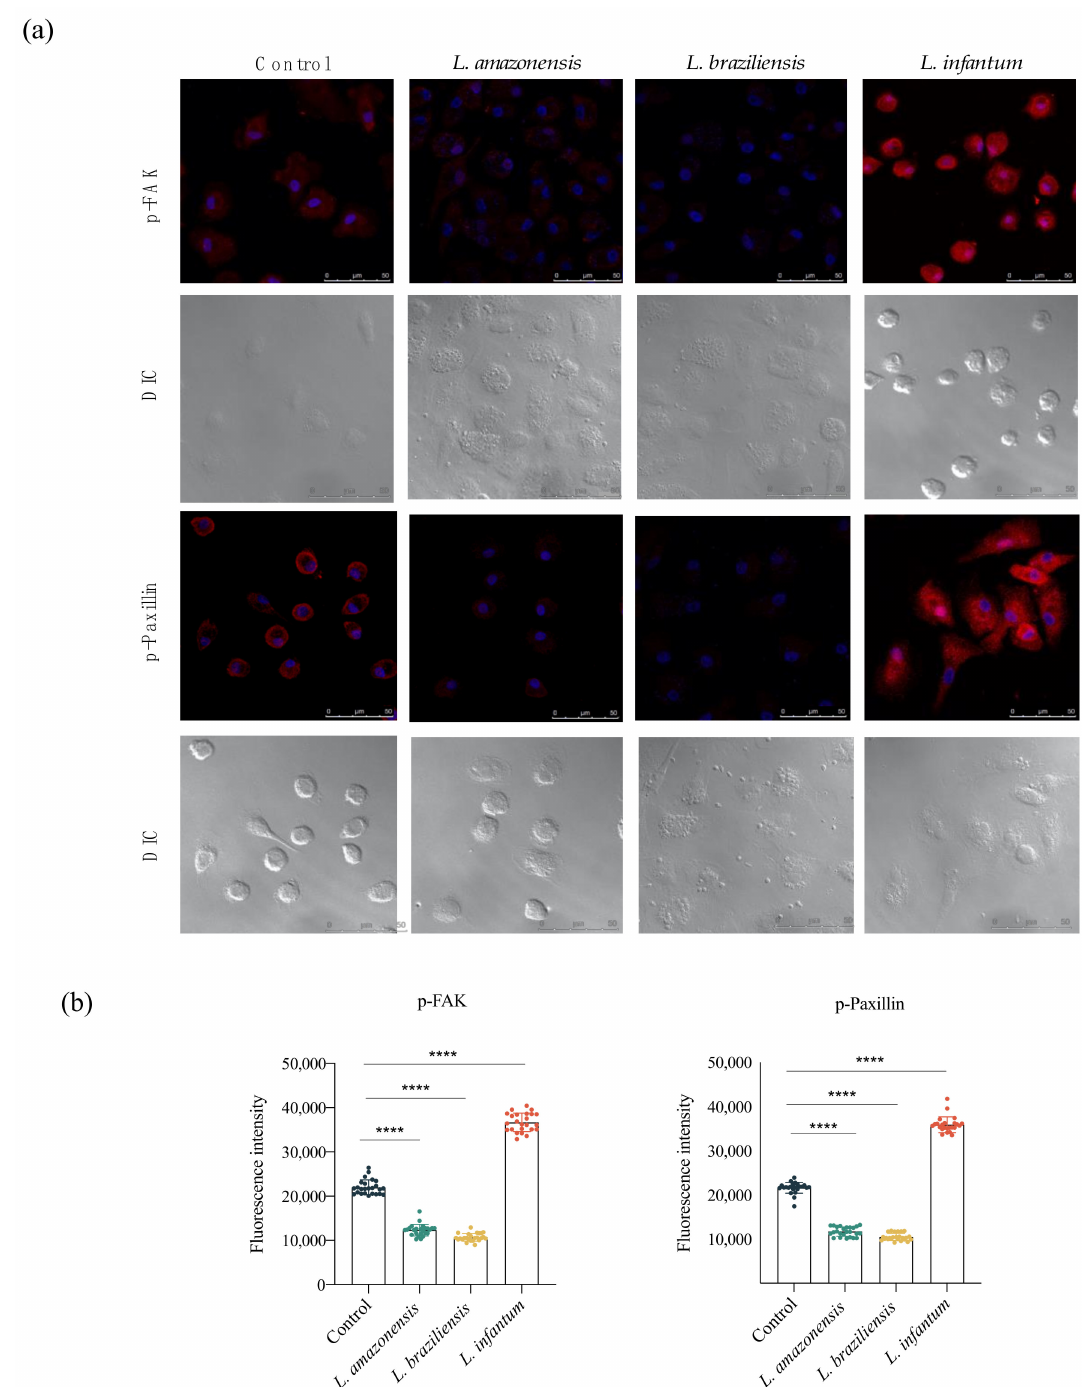
Figure 3. L. infantum induces hDC expression of adhesion complex proteins. Effects of Leishmania infection on phos- phorylated FAK and paxillin protein levels in hDCs infected or not with L. amazonensis , L. braziliensis or L. infantum. ( a ) Fluorescence intensity of FAK and paxillin labeling in hDCs infected with L. amazonensis , L. braziliensis or L. infantum . ( b ) Quantification of fluorescence intensity of FAK and paxillin after L. amazonensis , L. braziliensis or L. infantum infection. Fluorescence intensity was quantified in 30 cells from each infection condition. Red: anti-FAK or anti-paxillin; blue: DAPI; grayscale: differential interference contrast (DIC); Control, uninfected cells. **** p < 0.001 (ANOVA). Data are representative of three independent